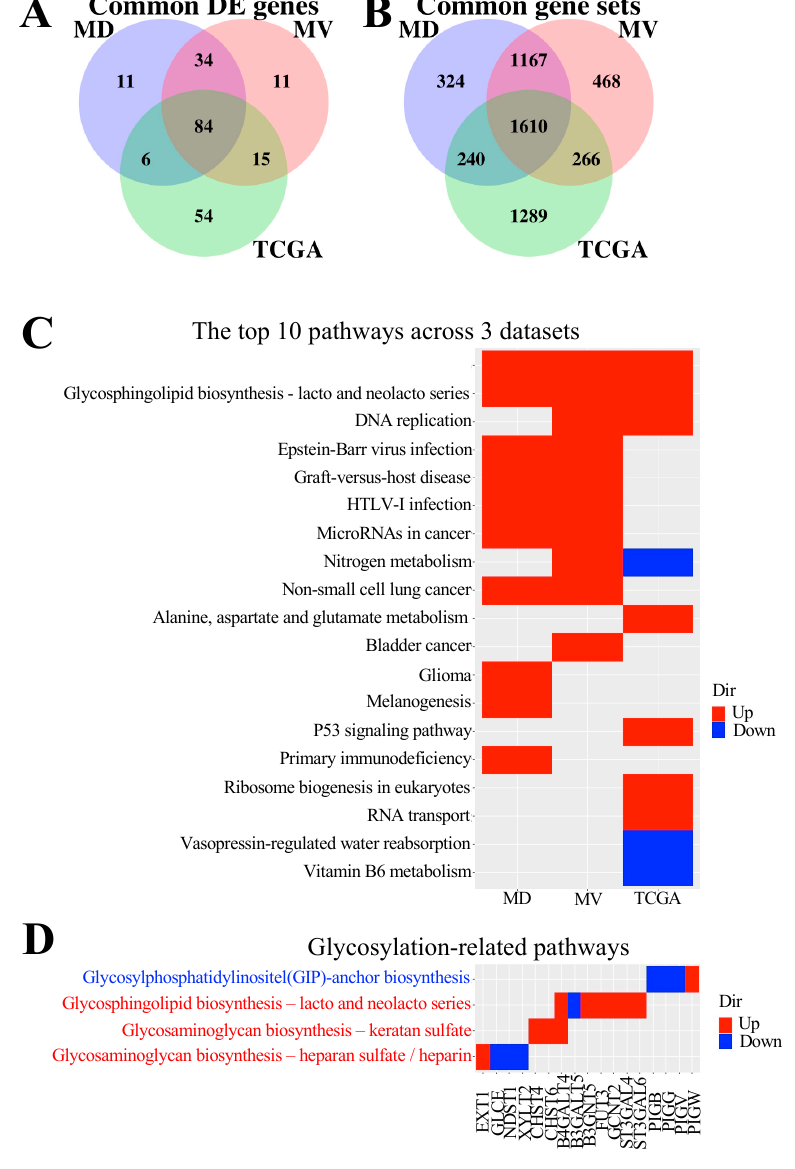
Figure 4. Differentially expressed (DE) genes and pathways for TNBC compared to non-TNBC/normal across three datasets. Venn diagrams showing common DE genes ( A ) and gene sets ( B ). ( C ) The top 10 enriched KEGG pathways across three datasets. ( D ) The common glycosylation-related pathways enriched across all three datasets, with blue font indicating down-regulated pathways, and red font indicating up-regulated pathways.